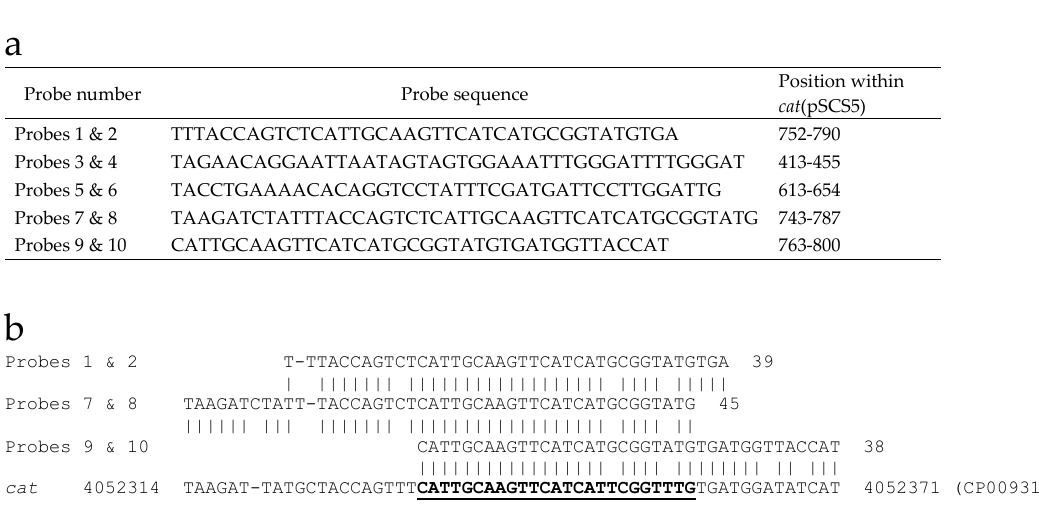
Figure 2. Source of false-positive calls for cat (pSCS5) in B. anthracis . ( a ) Sequences of cat (pSCS5) probes derived from S. aureus gene (accession no. M58515). ( b ) Alignment of probe sequences with B. anthracis cat gene (CP009315) represented on the ARDM v.3.1. The 25-nt sequence with 92% identity to the B. anthracis cat gene is underlined.